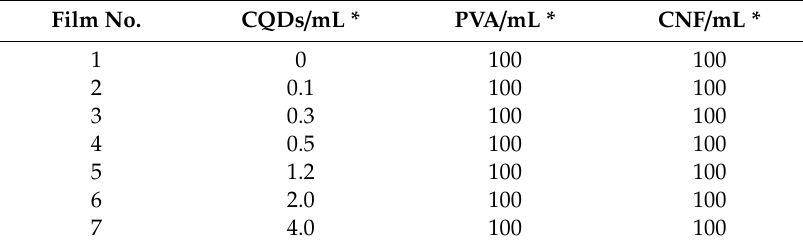
Table 1. The experimental scheme and formula of the